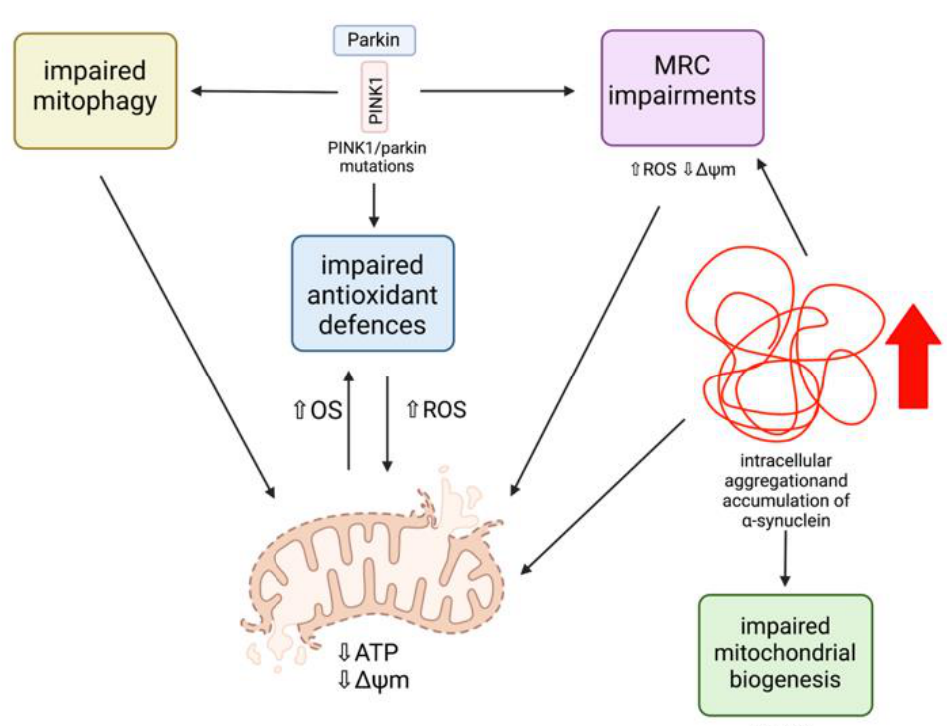
Figure 5. Mitochondrial dysfunction has a major role in the pathogenesis of Parkinson’s disease. Parkin/PINK1 mutations result in defective mitochondrial morphology, including MRC defects and impaired mitophagy. Parkin mutations can impair antioxidant defences, inducing oxidative stress and increasing ROS levels. α -Synuclein aggregation and accumulation (represented by up arrow) can increase oxidative stress resulting in increases in mitochondrial ROS production and mitochondrial fragmentation, altering the mitochondrial morphology. Intracellular α -synuclein aggregation impairs mitochondrial biogenesis via direct binding to the PGC1 α promoter, downregulating the PGC1 α expression. Both parkin/PINK1 mutations and α -synuclein accumulation cause reduced ∆Ψ m and ATP levels, leading to mitochondrial bioenergetic dysfunction and neurodegeneration (created using biorender.com). MRC—mitochondrial respiratory chain; ROS—reactive oxygen species; PGC1 α —peroxisome proliferator-activated receptor gamma coactivator 1-alpha; ∆Ψ m—mitochondrial membrane potential; ATP—adenosine triphosphate; PINK1—PTEN-induced kinase 1; OS—oxidative stress.